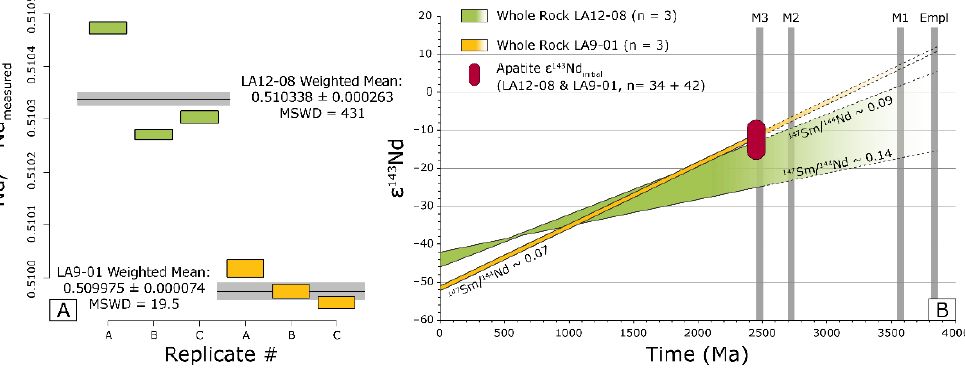
Figure 4. ( A ) Weighted mean diagram showing the measured 143 Nd/ 144 Nd whole-rock values for the three replicates (A,B and, C) of the amphibolite facies grey gneiss LA12-08 and metatexite LA9- 01. Diagram built with IsplotR [55]. ( B ) Evolution of the ε 143 Nd values back in the past. Empl.: Emplacement of the igneous